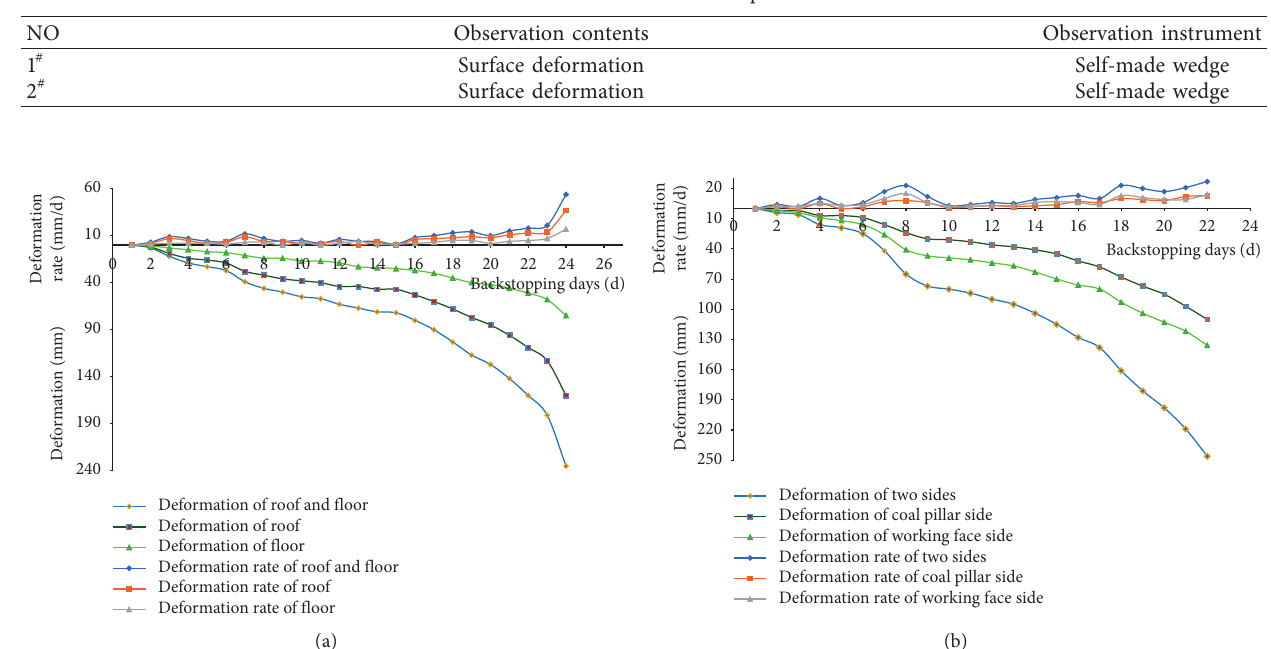
Table 4: Observations of mine pressure.